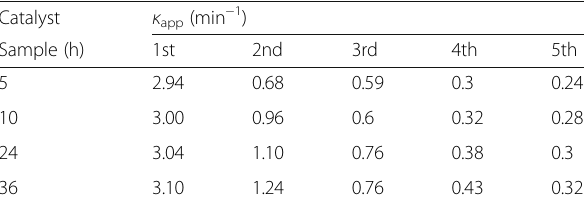
Table 1 The apparent rate constants κ app of different cycles for all samples